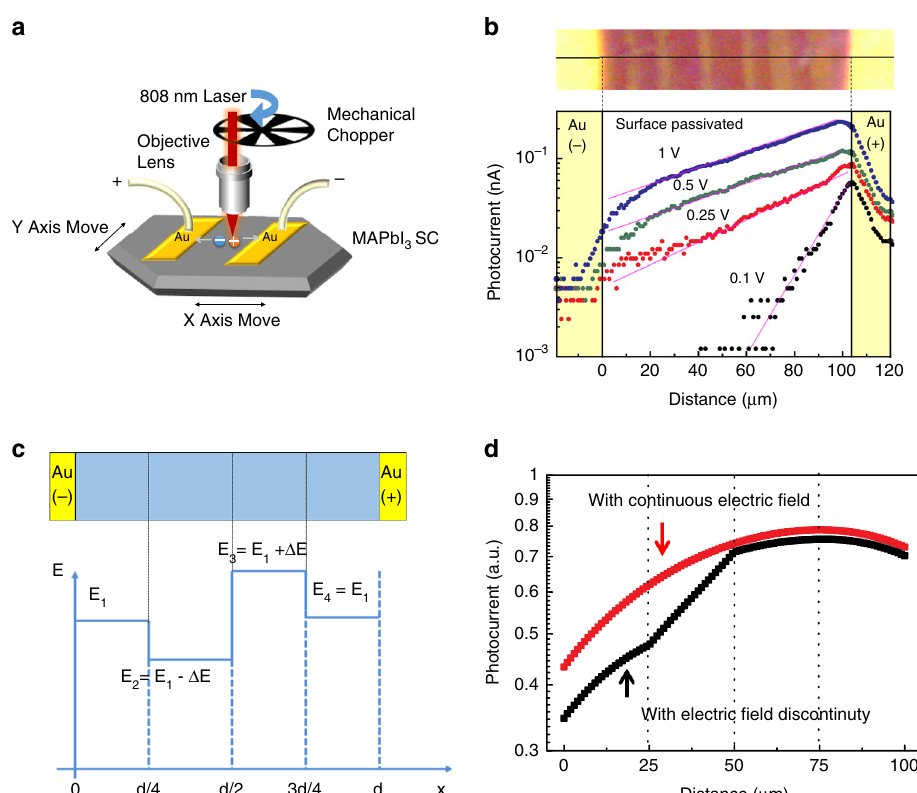
Fig. 2 Carrier transport probed by scanning photocurrent microscope (SPCM). a Schematic illustration of the SPCM setup. b Polarized optical image of the MAPbI 3 single crystal lateral device (upper panel) and the photocurrent line scan pro fi le across the conductive channel (lower panel) with increased electric fi eld from 1 V mm − 1 to 10 V mm − 1 after crystal surface passivation. The horizontal black solid line indicates the photocurrent line-scan trace, the pink solid line is a guide to eye. c Proposed electric fi eld distribution across the conductive channel. d The corresponding simulation results of the photocurrent pro fi le without and with the electric fi eld